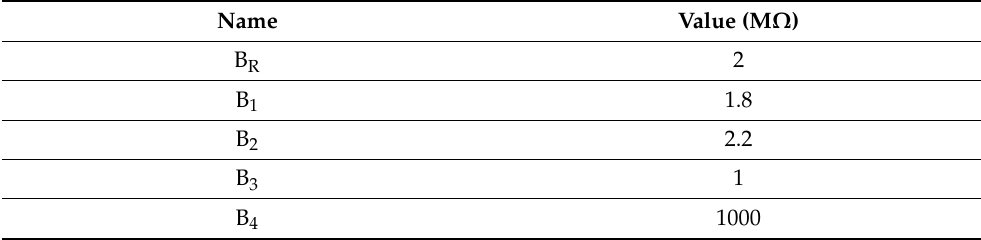
Table 2. List of burdens selected for the